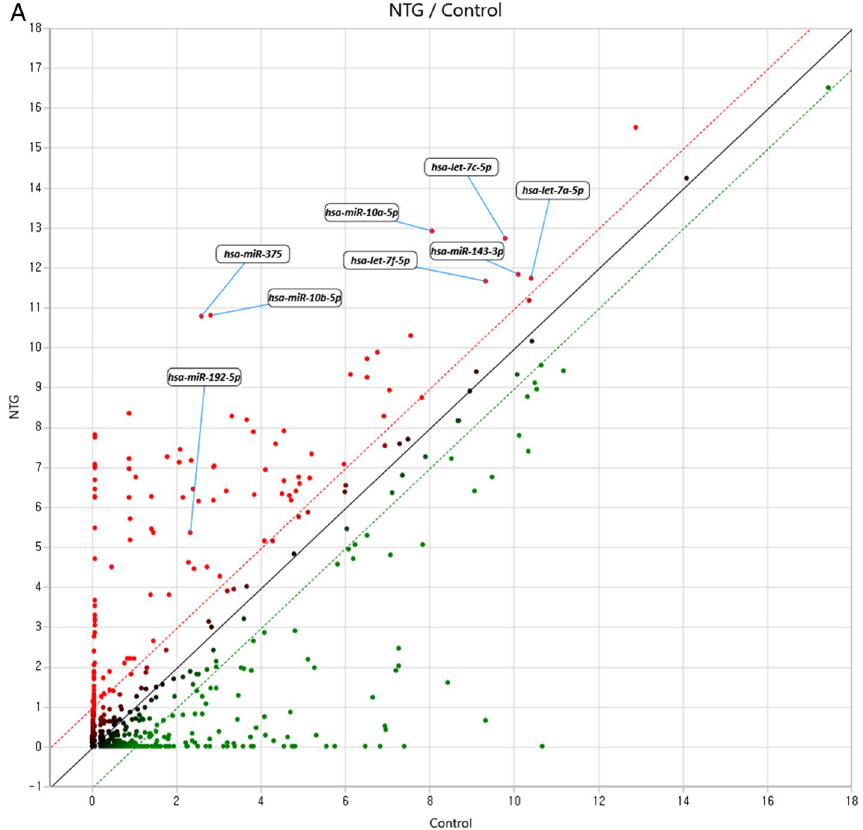
Figure 1. Scatter plot and volcano plot of the comparison of miRNA expression in aqueous humor from subjects with NTG versus unaffected controls. ( A ) Up-regulated miRNAs are shown to the upper region of the scatter plot (red) and down-regulated miRNAs are shown to the lower region of the scatter plot (green). A total of 228 mature miRNAs were identified in the aqueous humor of the NTG patients. Eight miRNAs, hsa-let-7a-5p, hsa-let-7c-5p, hsa-let-7f-5p, hsa-miR-192-5p, hsa-miR-10a-5p, hsa-miR-10b-5p, hsa-miR-375, and hsa-miR- 143-3p were significantly up-regulated in NTG group compared to normal control. Fold change > 2 (red dotted line), fold change < − 2 (green dotted line); Normalized data (log2) > 4; p -value < 0.05 versus control. ( B ) In volcano plot, up-regulated miRNAs are shown to the right of the plot (red) and were only selected which passed the thresholds of p < 0.05 (horizontal black dotted line) and fold change > 2 (red vertical dotted line). Down- regulated miRNAs are shown to the left of the plot (green) and were only selected which passed the thresholds of p < 0.05 (horizontal black dotted line) and fold change < 2 (green vertical dotted line). After selecting only those with Normalized data (log2) > 4, the volcano plot shows eight significantly upregulated miRNAs with fold change > 2, and p -value < 0.05. Of these, eight miRNAs were significantly up-regulated compared to the controls (fold-change > 2, p < 0.05), in addition to the analysis of the fold-changes were selected which only based on the normalized array data (log2) > 4. There was no significantly down-regulated miRNAs identified in NTG patients compared to control subjects according to the same significance criteria. Plots were presented by ExDEGA v1.2.1.0 software. NTG normal tension